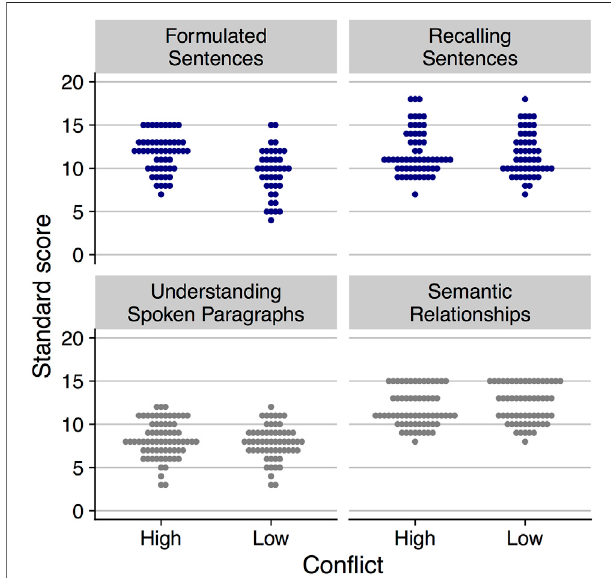
FIGURE 1 | Beeswarm plots showing individual variation of standard scores in each con fl ict condition for the four CELF-5 subtests. Expressive language measures are shown in blue; receptive language measures are shown in gray. Points are jittered along the x-axis to promote visualization of overlapping